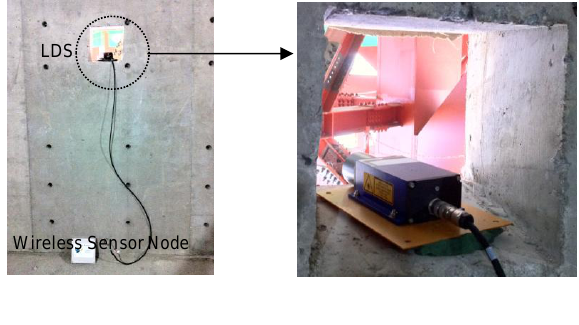
Figure 6. Wireless laser displacement measurement devices (LDS and wireless sensor node).